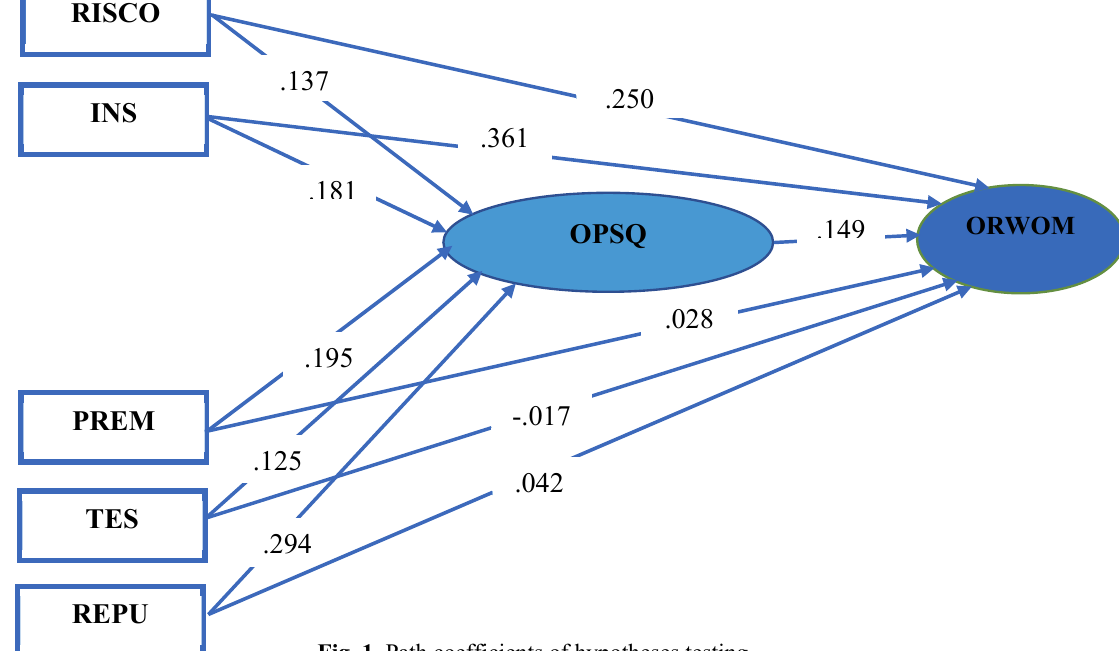
Fig. 1. Path coefficients of hypotheses testing